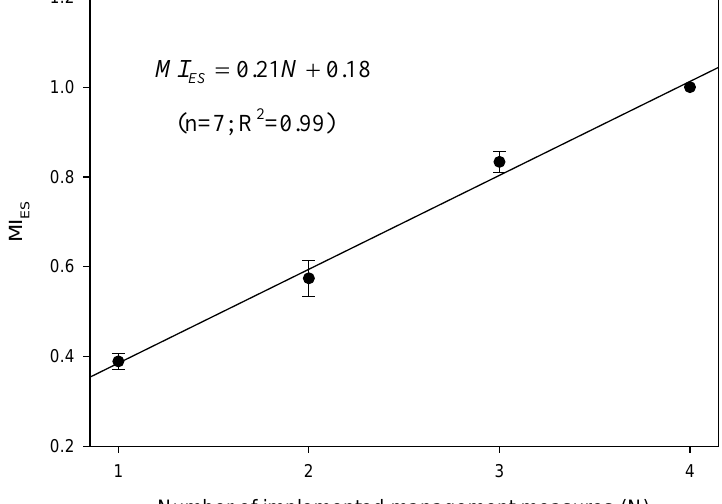
Figure 3. The relationship between MI (mean ± 95% confidence interval) and the ES corresponding number of management measures implemented in the workplace